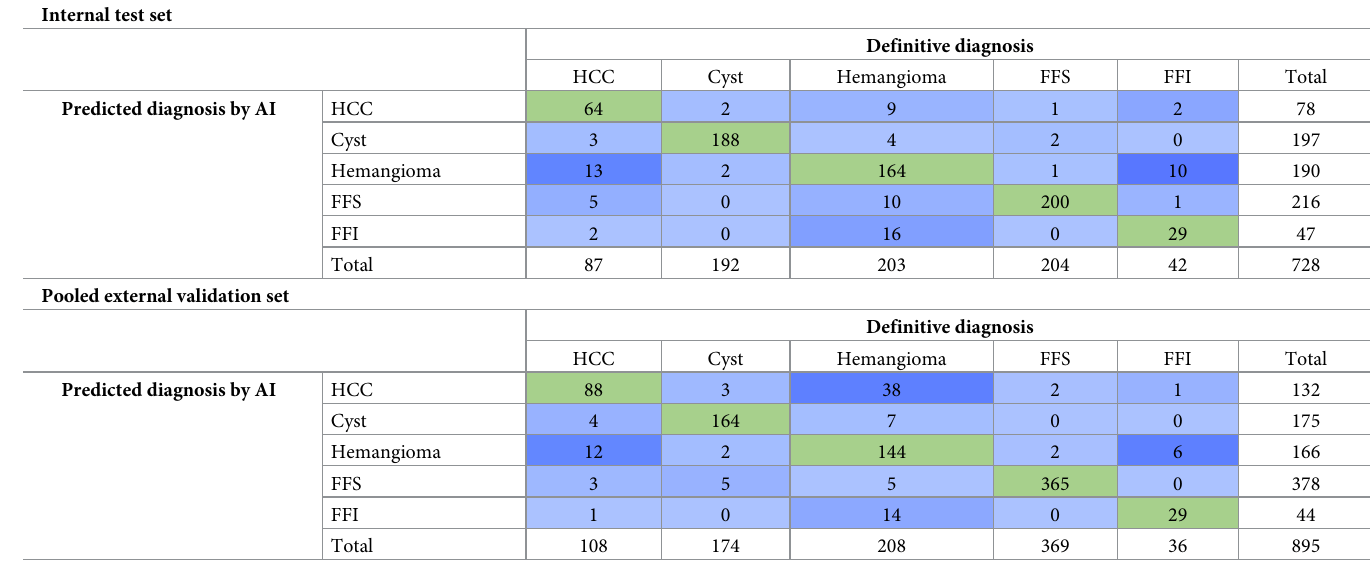
Table 3. Confusion matrix for classification results on internal test set and external validation set.